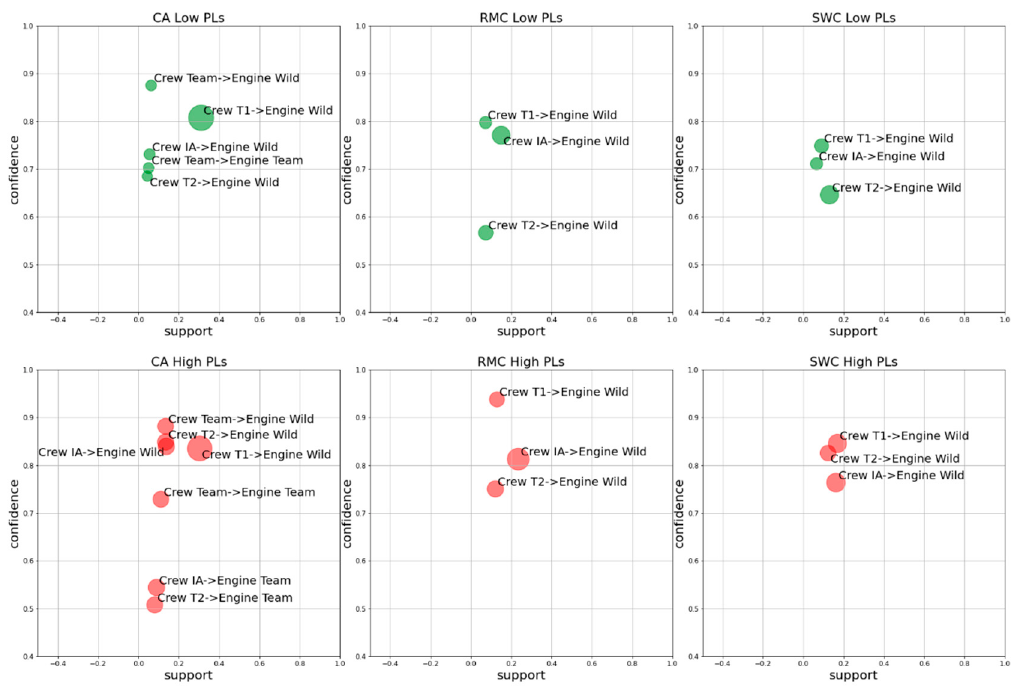
Figure 7. Association rules (support >5% and confidence >50%) from crew subcategories to engine subcategories for daily assignments in three GACCs at two PL levels. Engine Wild: wildland engine; Crew T1: type 1 crew; Crew T2: type 2 crew; Crew IA: initial attack crew.